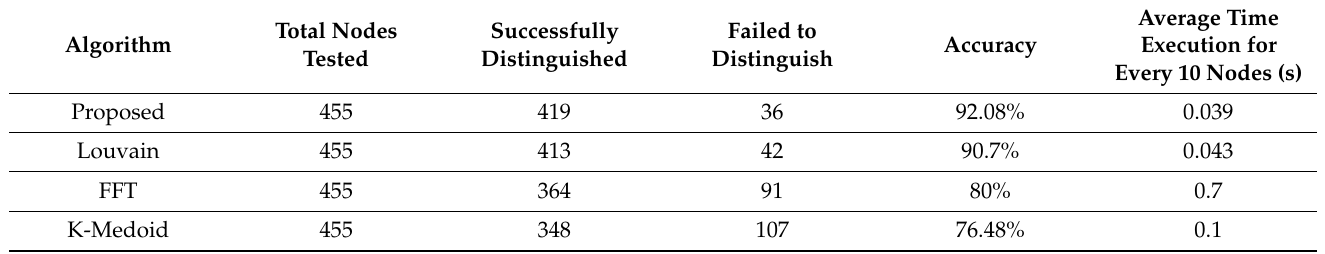
Table 3. The performance of the proposed algorithm against the